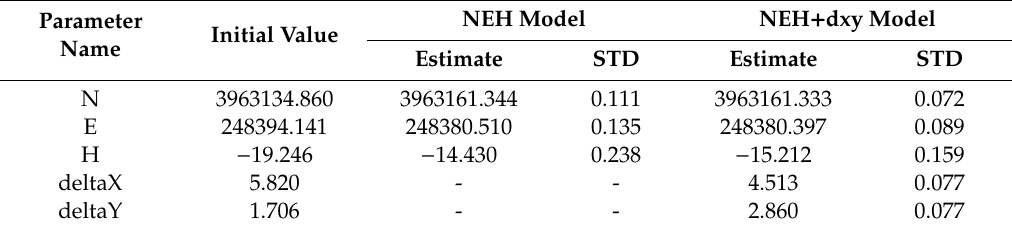
Table 2. Results of Two Estimation Model (Unit: m).